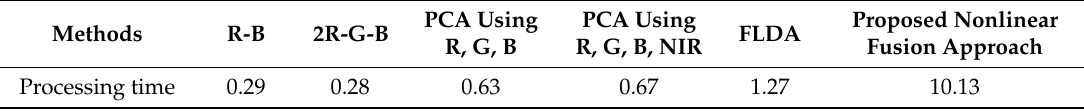
Table 5. Processing time (second) for different classification